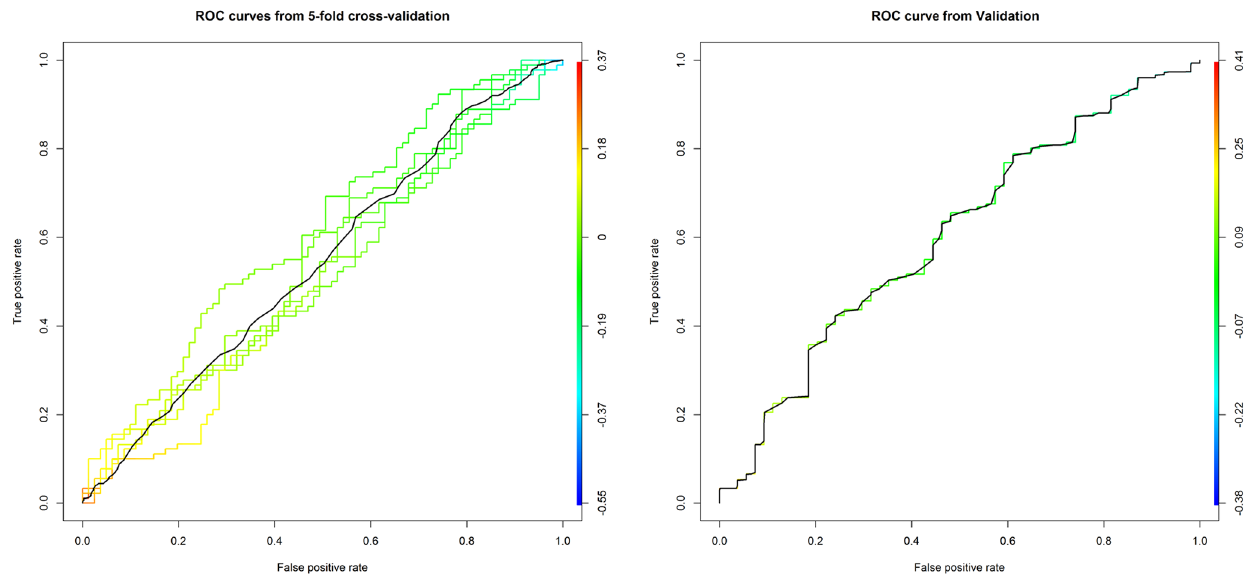
Figure 3. Receiver Operating Characteristics (ROC) curve for five-fold cross-validation and for application of results from discovery data to validation data. Models were developed using a Bayes C analysis implemented in GenSel. Each curve represents one model, with the black line in the figure on the left representing the average of the five-fold cross-validations. Area under the ROC curve is equivalent to the probability that the classifier will rank a randomly chosen positive instance higher than a randomly chosen negative instance. A diagonal line from the lower left to upper right corner would represent a model with no predictive